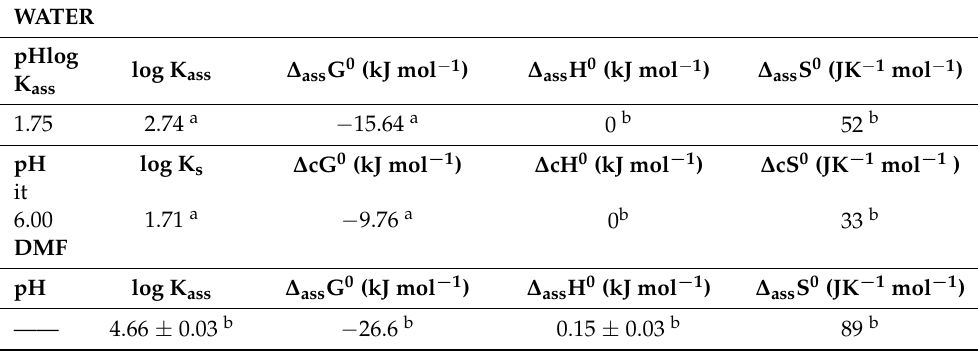
Table 7. Thermodynamic data for the interaction of nonionized (pH 1.75) and ionized